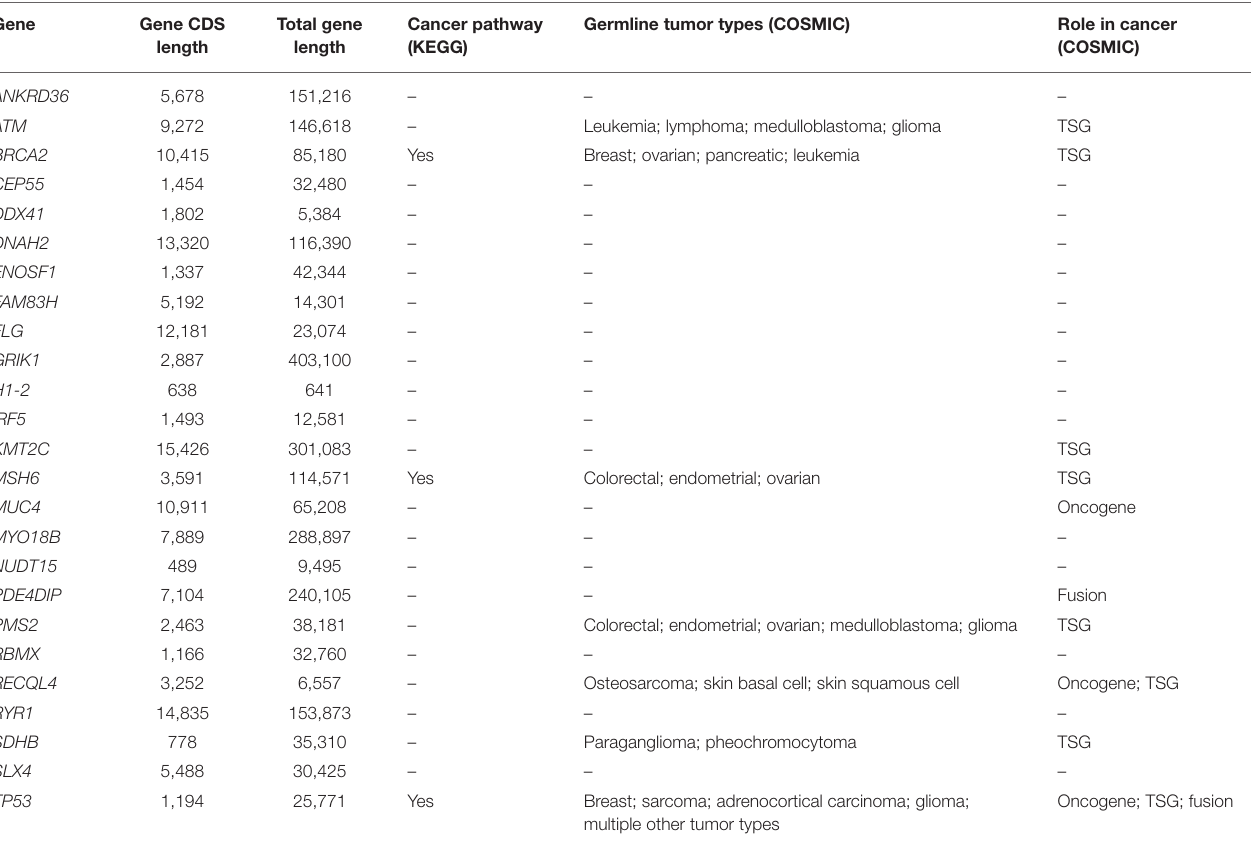
TABLE 2 | Details of genes with identified CH